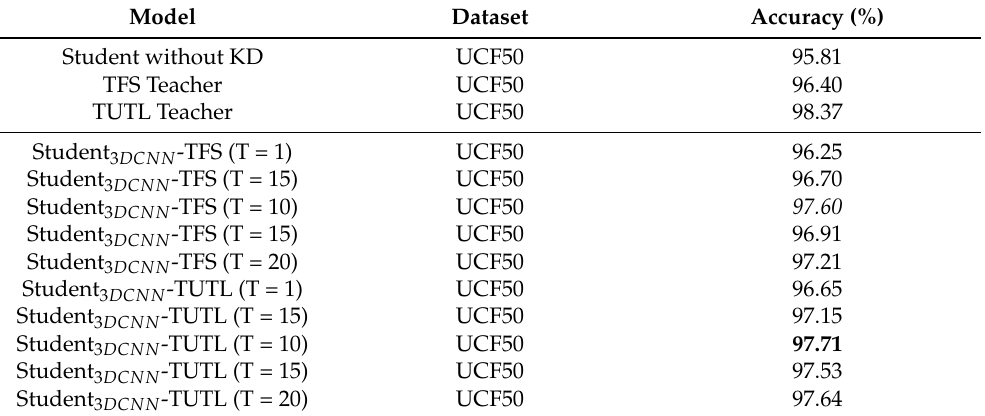
Table 5. Quantitative comparative analysis of the results obtained by our proposed framework with and without knowledge distillation (KD) with different settings over UCF50